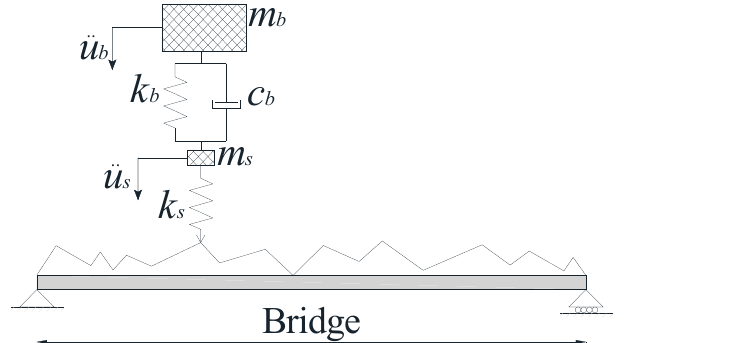
Figure 9. Theoretical quarter car model.